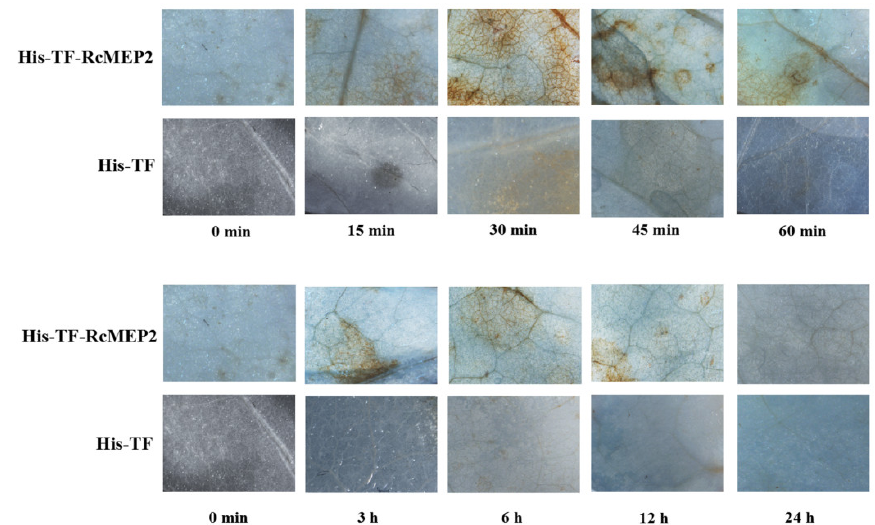
Figure 8. H 2 O 2 accumulation triggered by RcMEP2 in the infiltrated N. benthamiana leaves. H 2 O 2 accumulation (as indicated by diaminobenzidine staining) appeared obviously in the veins and stomata of His-TF-RcMEP2 infiltrated leaves but not obviously in leaves infiltrated with 5 µM His-TF-tag solution (CK). These stains were observed and photographed under a stereomicroscope. Bar, 2 mm.